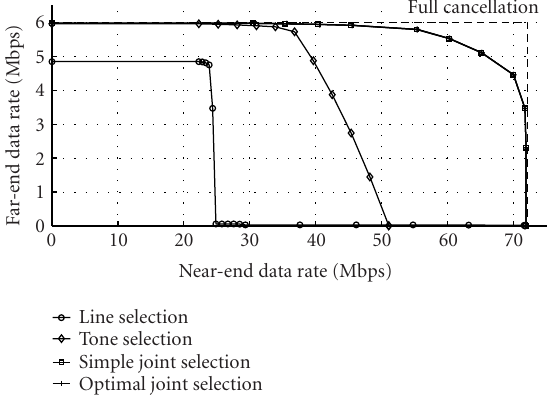
Figure 9: Achievable rate regions of di ff erent algorithms ( c =